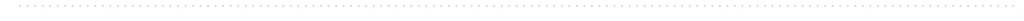
Figure 5. Evaluation of AAV1-U7ex23 benefit in cardiotoxin regenerated and mdx muscles. Wt, wt + CTX and mdx TAs were injected with AAV1-U7ex23 and the mice were sacrificed 3 weeks later. ( A ) Level of U7ex23 RNA estimated by relative qPCR and expressed as a percentage of U7ex23 present in wt muscles. Non inj., wt non-AAV injected TA. ( B ) Quantification of AAV genomes per nucleus by absolute qPCR in wt, wt + CTX and mdx muscles injected with AAV- U7ex23 vector and corrected by the correcting factors. AAV genome content is expressed as the AAV genome number relative to the value obtained for wt muscles. ( C ) U7ex23 RNA amount normalised by the AAV genome numbers and expressed as a percentage of wt RNAs. ( D ) Level of exon 23 skipping estimated by nested RT-PCR. The 901 bp PCR product corresponds to full-length dystrophin transcripts whereas the 688 bp product corresponds to transcripts lacking exon 23. ( E ) Quantification of exon 23 skipping by relative qPCR and expressed as a percentage of total dystrophin transcripts. ( F ) Quantification of dystrophin (dys) transcripts by relative qPCR. Relative amount of dys transcripts is expressed as a percentage of wt RNAs. The data represent the mean values of four TAs per group ± SEM. Student’s t-test: n.s. non-significant, *P ≤ 0.05, **P ≤